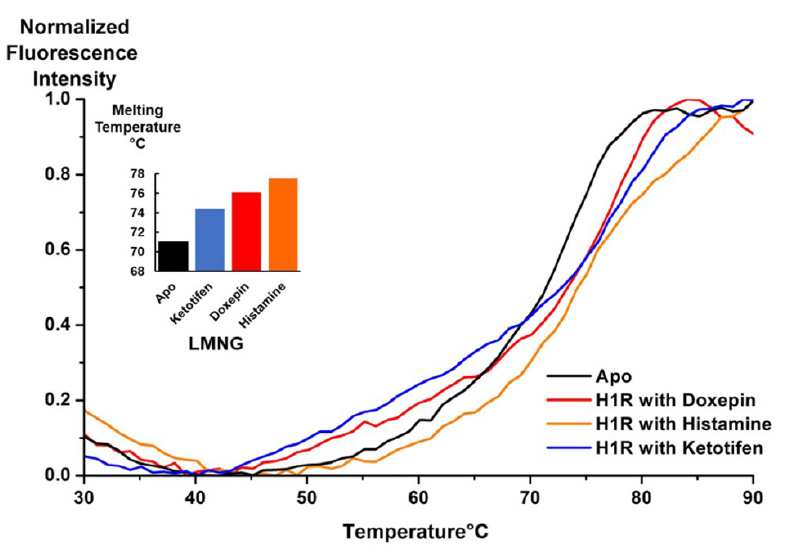
Figure 4. Fluorescence thermal shift assay curves are plotted for purified H 1 R in complex with several ligands and for a sample with no ligand added (apo). The experimental data were fitted to a Boltzmann sigmoidal function to calculate the unfolding temperatures (T M ) of each sample, shown in the inset. Each experimental curve was normalized relative to the maximum observed fluorescence intensity.